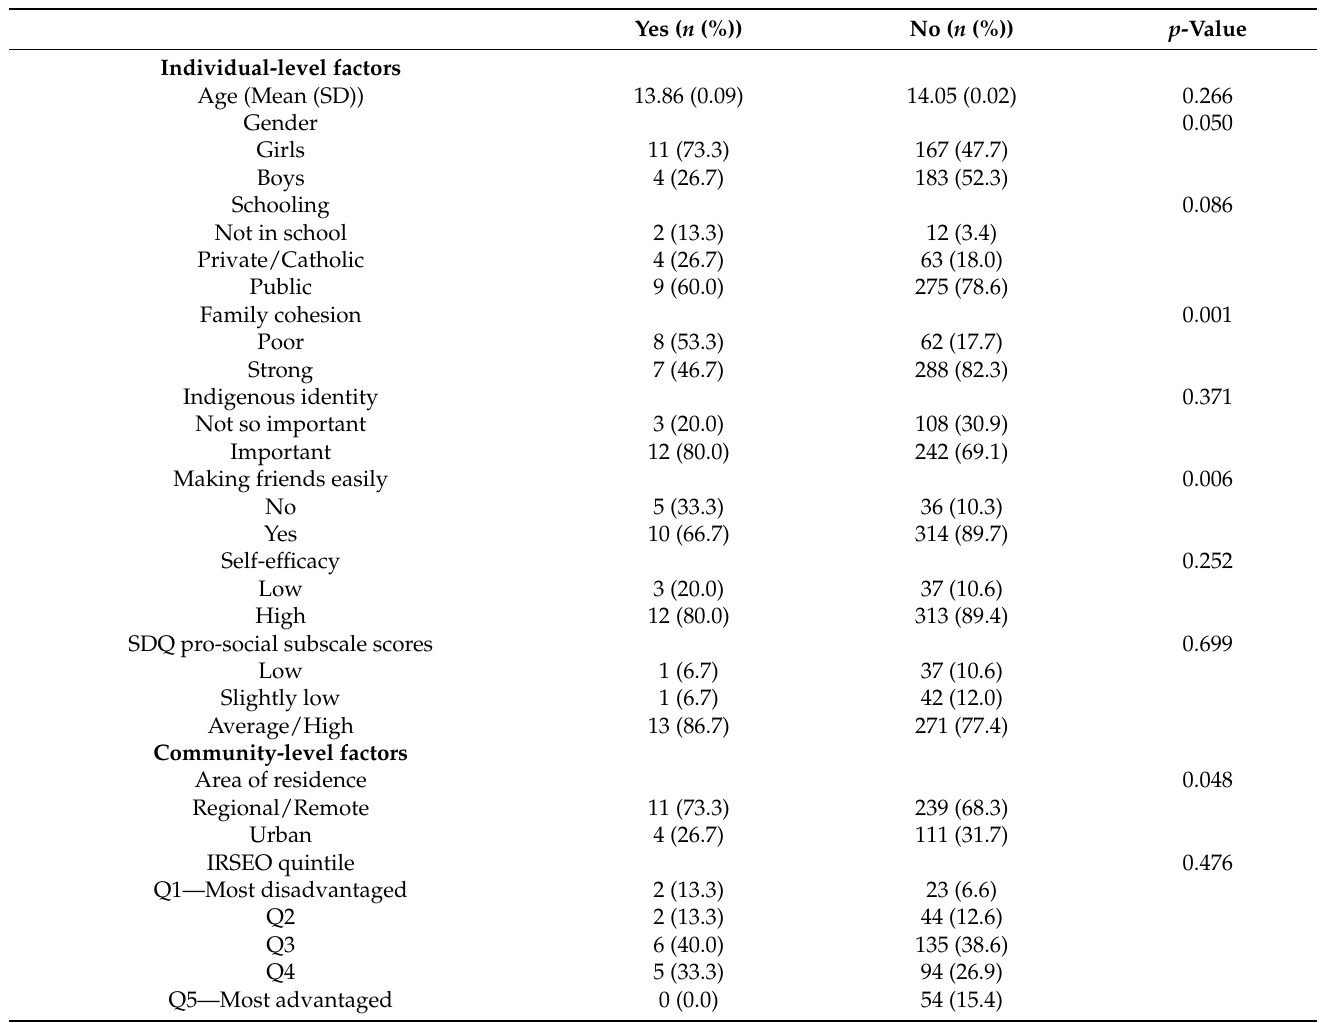
Table 4. Factors associated with suicidality (bivariate